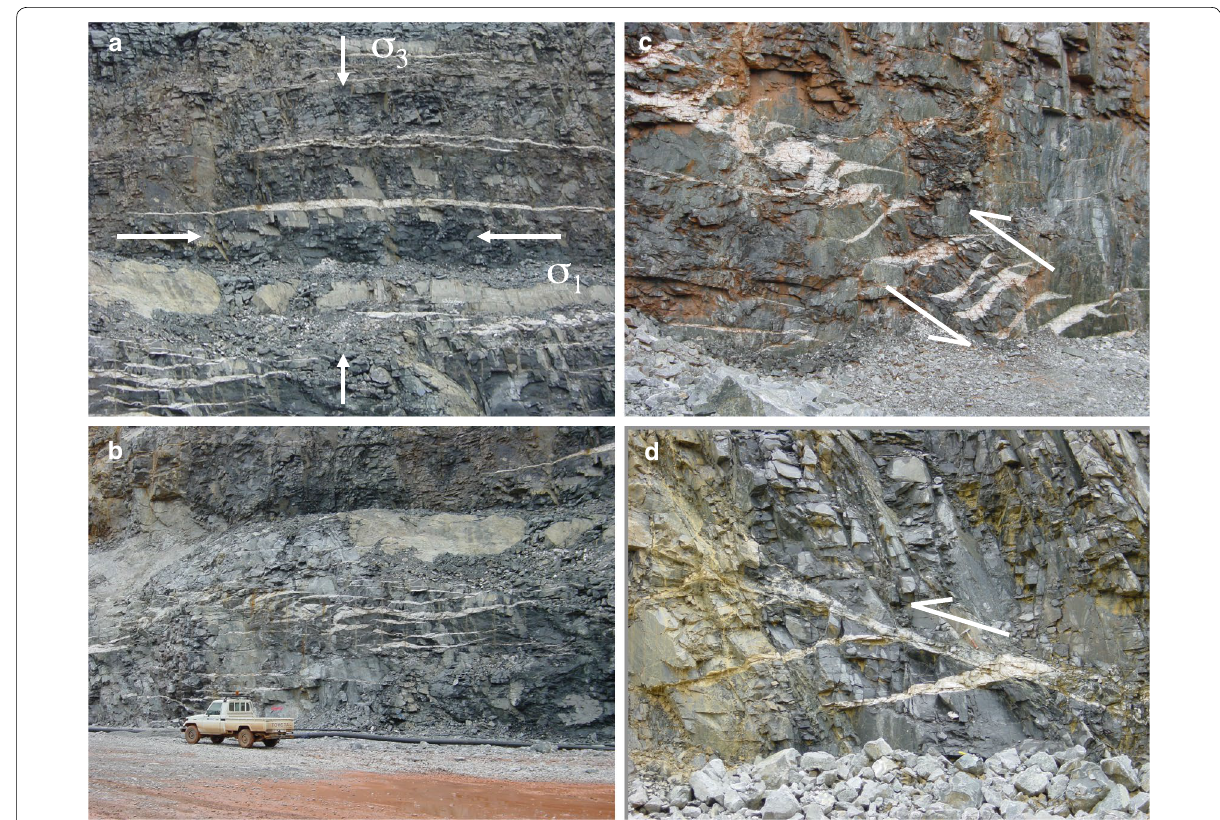
Fig. 8 Au-bearing quartz vein swarm at Damang Gold Mine, Ghana (from Tunks et al. 2004): a array of subhorizontal extension veins cutting steeply dipping Paleoproterozoic meta-sandstones; b subhorizontal extension veins locally evolving into a thrust-sense tension-gash shear zone under horizontal compression; c thrust-sense sigmoidal tension-gash shear zone; d mineralized thrust fault cutting through tension-gash shear zone (photographs courtesy of Andrew